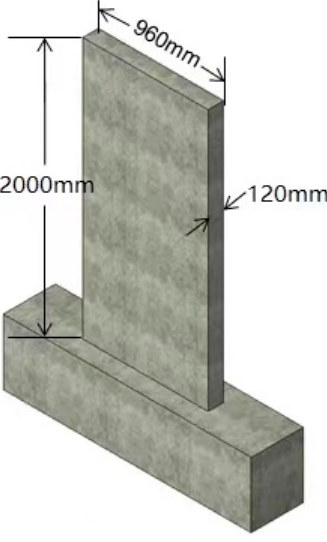
Figure 1. Schematic of the test wall specimens.